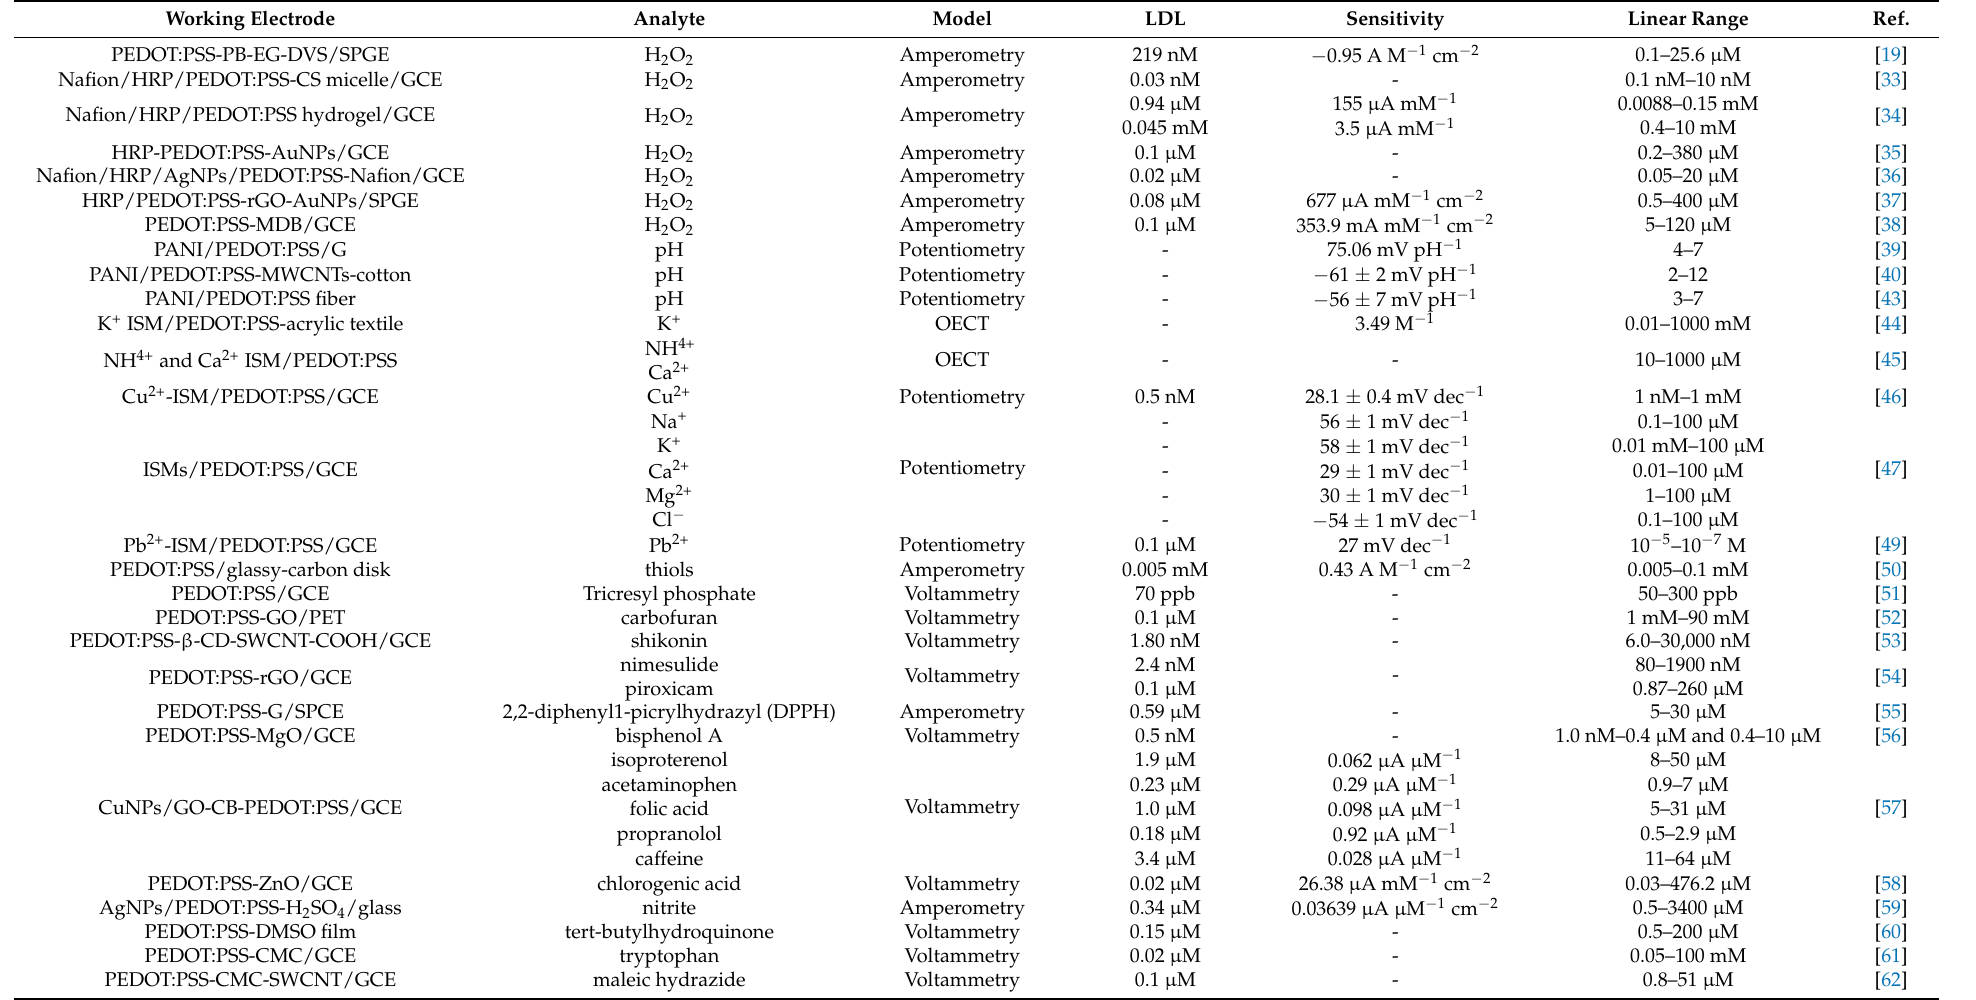
Table 1. Comparison of PEDOT:PSS-based electrochemical chemosensors for different